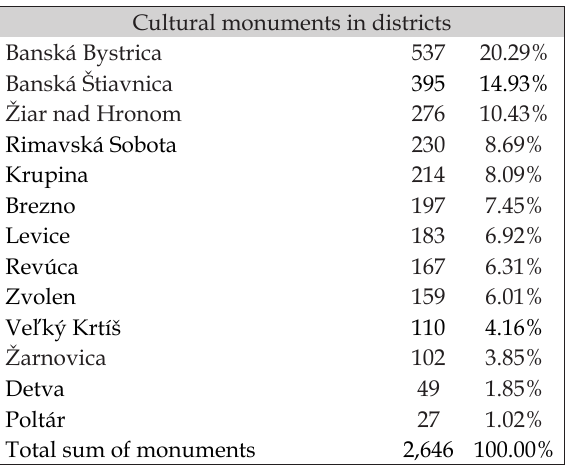
Table 1. Cultural and historical heritage in the Banská Bystrica region.